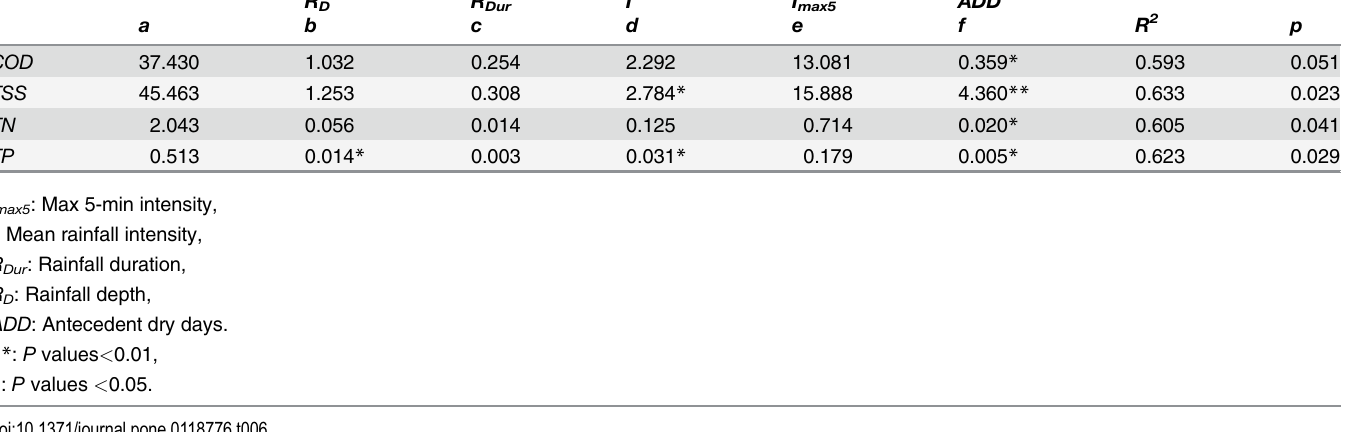
Table 6. Multiple linear regression results for the storm pollution loads of FF 40 ( |FF 40 | ) of Tongsha reservoir watershed. R R I I ADD D Dur max5 a b c d e R 2